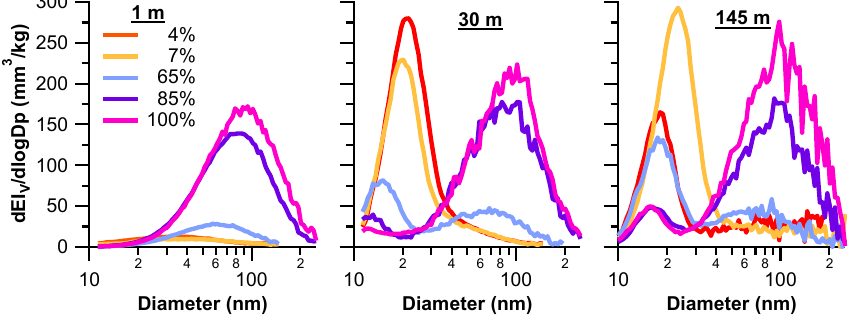
Fig. 6. Volume-weighted size distributions at 1, 30, and 145m behind the exhaust plane for JP-8 fuel during one engine test (i.e., at constant ambient temperature). Data are solely from the #3 engine.